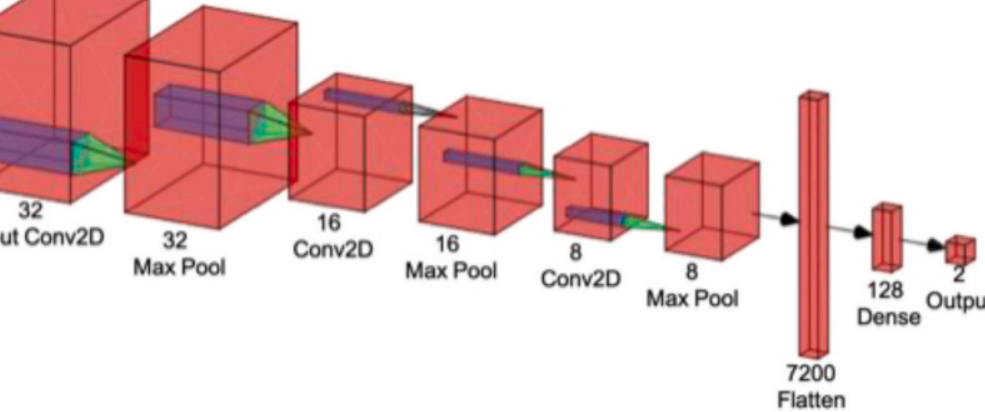
Figure 4. The basic architecture of convolutional neural network [22] (reproduced with permis- sion).